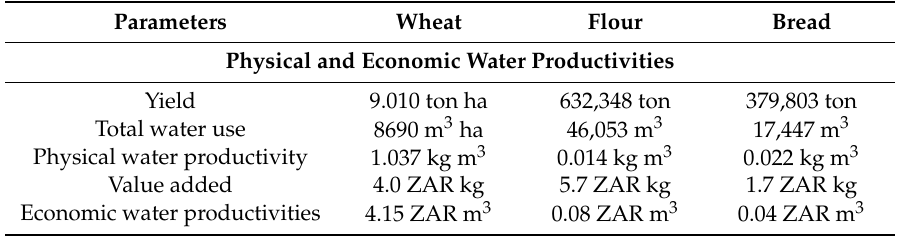
Table 6. Physical and economic water productivity of wheat, flour and bread along the wheat-bread value